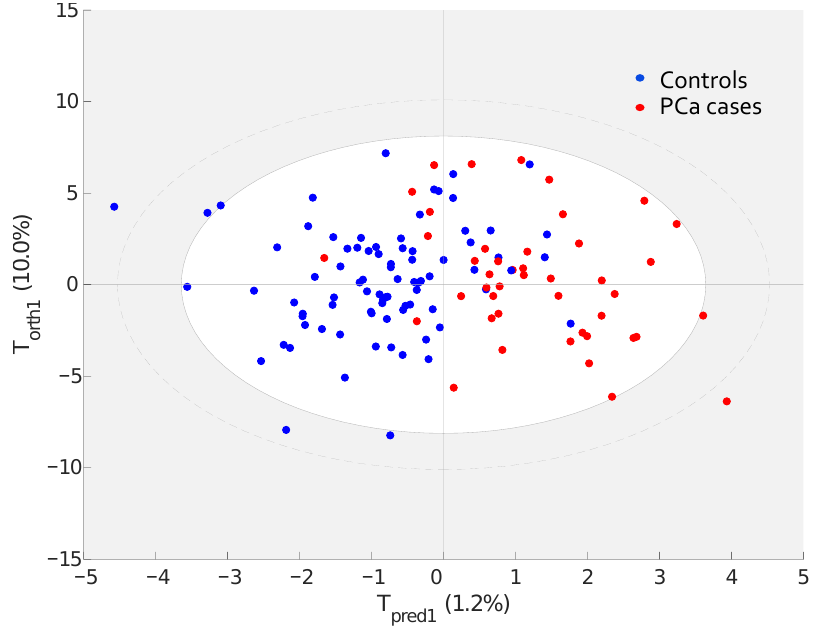
Figure 2. Projection of validation cohort samples using discovery cohort OPLS-DA model. Validation cohort, PCa cases ( n = 44; red circle), matched controls ( n = 82; blue circle). Corresponding AUC: 0.92 (sensitivity: 86.36%; specificity: 86.59%), 95% confidence interval (0.87, 0.97), p value: < 0.0001.